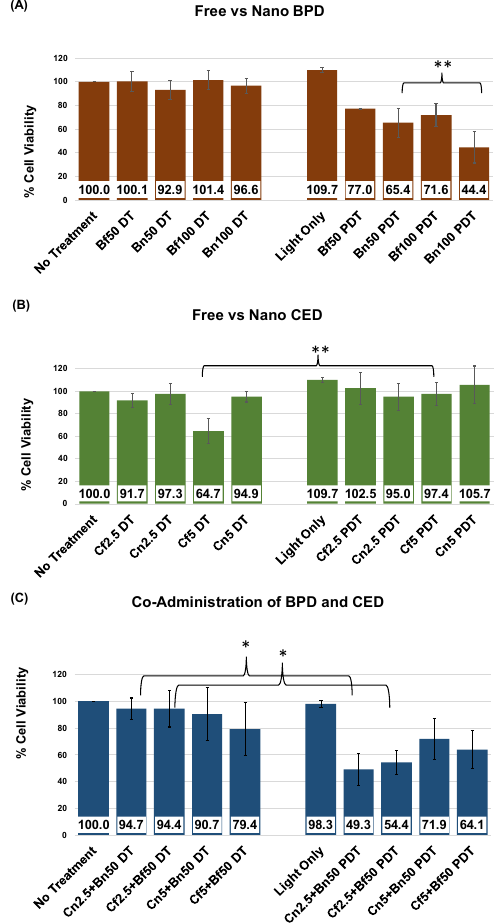
Figure 8. Effect of BPD and CED on U87 cellular survival as shown by free and NP formulation cell viability assay results of individual drugs, ( A ) BPD and ( B ) CED, at varied concentrations to assess optimal dose for cell death in the ( C ) co-administration of free or NP C2.5 or C5, and B50, simultaneous dosing where both CED and BPD were either in free or NP form, and incubation for 1 h. PDT treatment was consistent at 2.5 J/cm 2 , 100 mW/cm 2 , and 25 s exposure time. MTT assay analysis was performed at 24 h following PDT. All experiments shown were performed in triplicate. Differences with p < 0.05 were considered statistically significant using the Student’s t -test (* p <0.05, ** p < 0.01). DT, dark toxicity; PDT, photodynamic therapy; C, cediranib; B, bpd; f, free drug; n, NP formulation of drug; 2.5, 2.5 uM cediranib; 50, 50 nM bpd.